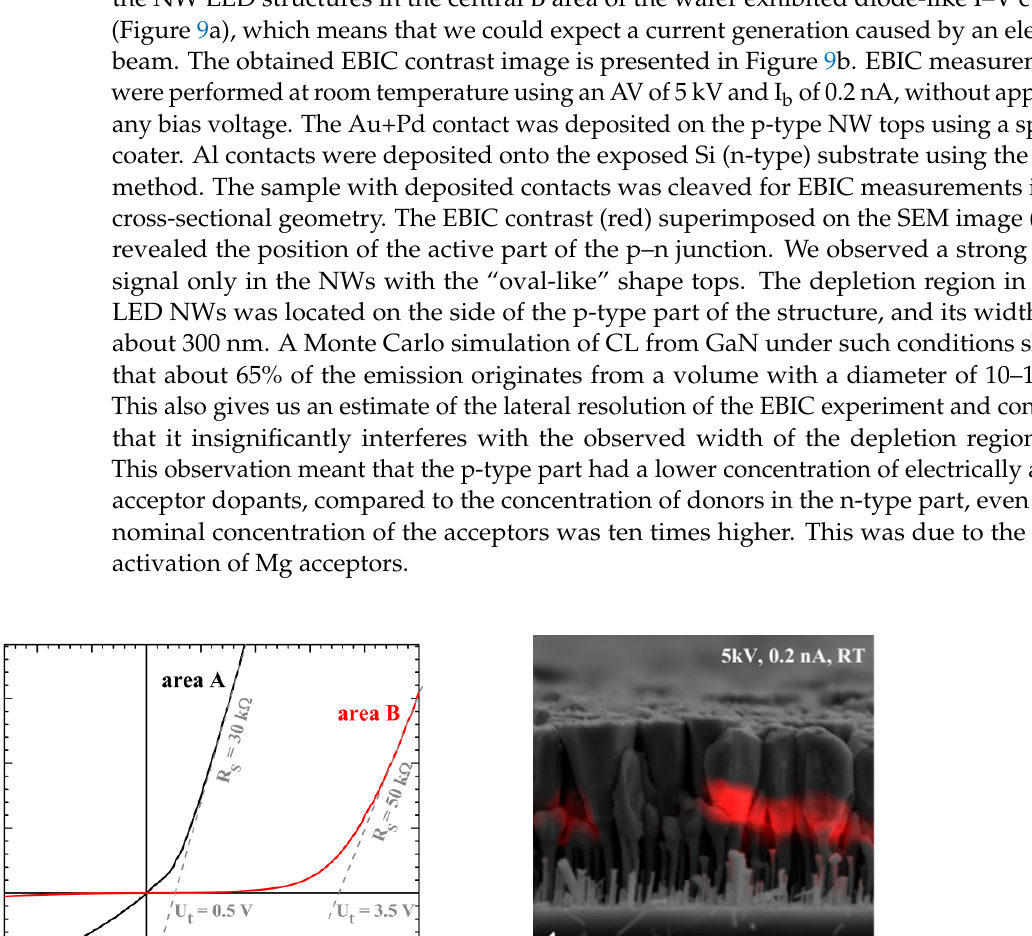
Figure 10. Series of I–V curves (central panel) of individual nanowires (NWs) (black curves: hexagonal top NWs; red curves: irregular NWs) and corresponding SEM images, showing the geometry of the measurements (sides). The sharp hexagons (black curves) exhibit nonlinear, symmetrical I–V curves with a low turn-on voltage, while the NWs with rounded edges (red curves) exhibit nonlinear and nonsymmetrical diode-like I–V curves.